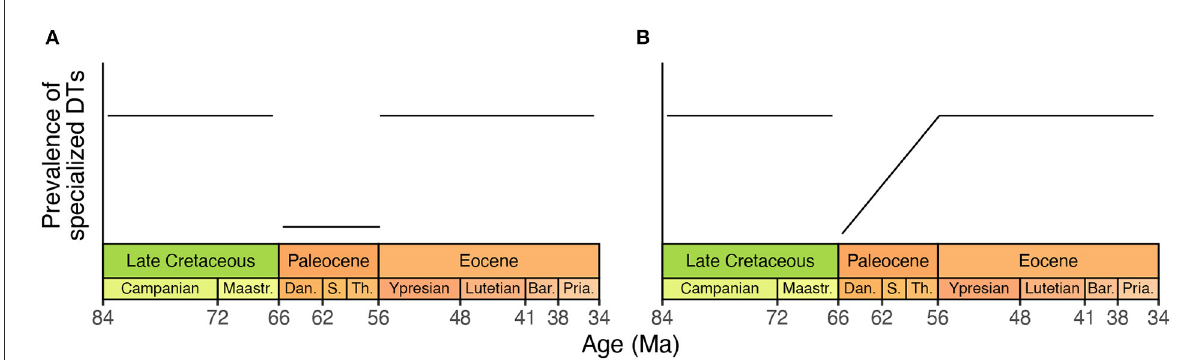
FIGURE3 A hypothetical illustration, showing the prevalence of specialist herbivores from the Cretaceous through Eocene according to Currano et al. (2021). (A) A literal interpretation of the scenario that the original study outlined for specialized herbivory during the Cretaceous, Paleocene, and Eocene. (B) An alternative scenario that conforms to the proposed trajectory of specialized herbivory through time while incorporating the potential for the diversity of herbivory to vary within the Paleocene. The timescale used here is from Cohen et al. (2013).